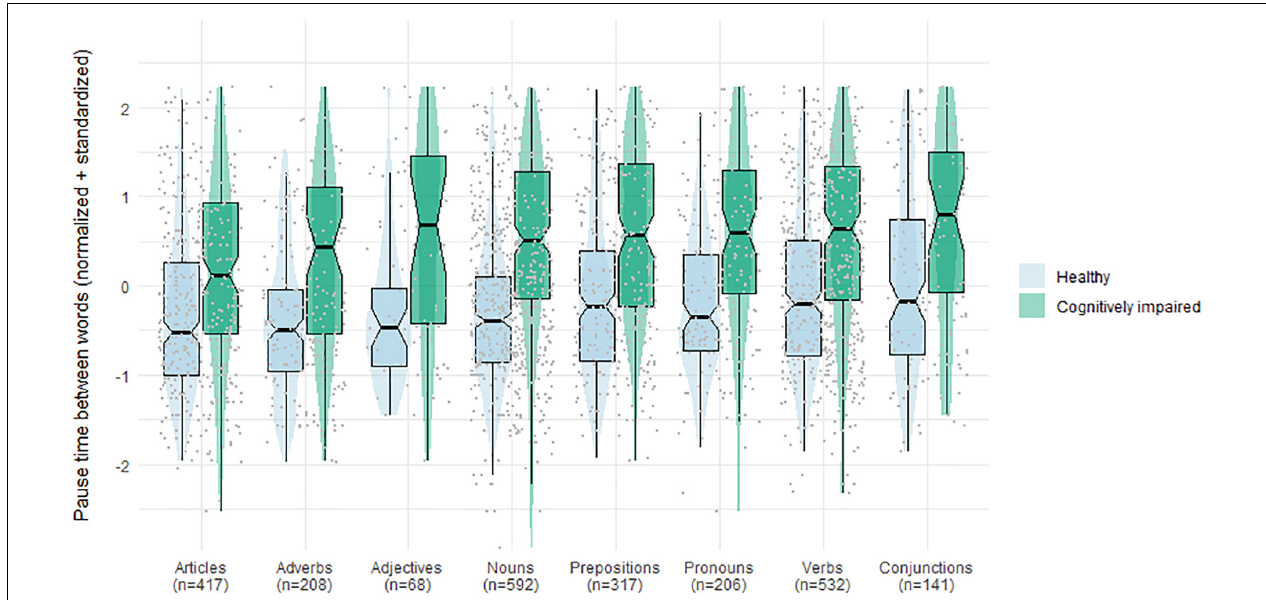
FIGURE 3 | Number of pauses and distribution of pause length per word category for healthy controls and cognitively impaired patients.